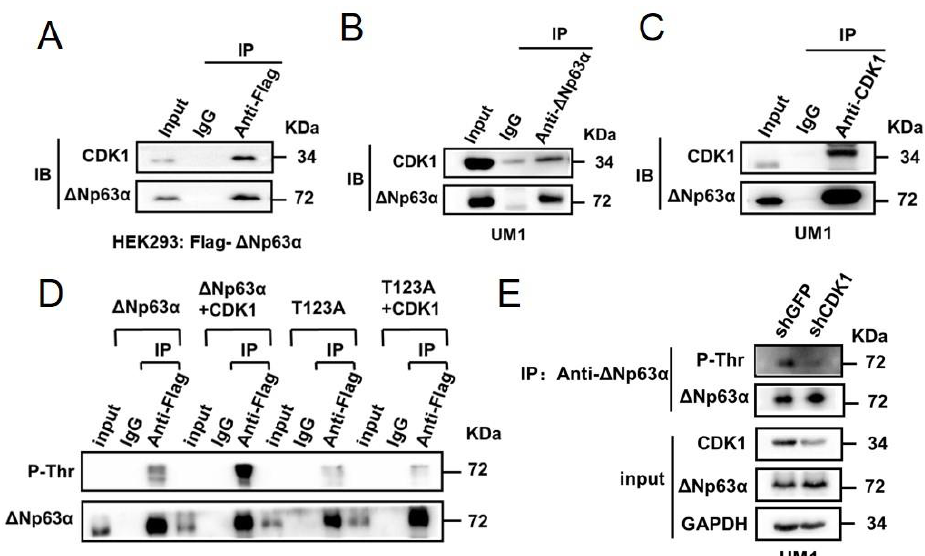
Figure 1. CDK1 binds to ∆ Np63 α and phosphorylates it at T123. ( A ) HEK293 cells transfected with Flag- ∆ Np63 α were lysed and subjected to immunoprecipitation (IP) with anti-Flag or IgG control. The cell lysate (input) or IP products were subjected to immunoblot (IB) analysis to detect indicated proteins. ( B , C ) UM1 cells were lysed and subjected to IP with anti- ∆ Np63 α or anti-CDK1, using homologous IgG as controls. The cell lysate (input) or IP products were subjected to immunoblot (IB) analysis to detect indicated proteins. ( D ) HEK293 cells transfected with Flag- ∆ Np63 α or its T123A mutant, plus CDK1, were lysed and subjected to IP with anti-Flag or IgG control. The cell lysate (input) or IP products were subjected to IB analysis to detect indicated antigens. P-Thr, phosphorylated threonine. ( E ) UM1 cells were infected with lentivirus-based shRNA specific to CDK1 (shCDK1#1, using shGFP as a control) and selected with puromycin. The resultant stable cell lines were lysed and subjected to IP with anti- ∆Np63α. Then the cell lysate (input) or IP products were subjected to immunoblot (IB) analysis to detect indicated antigens.